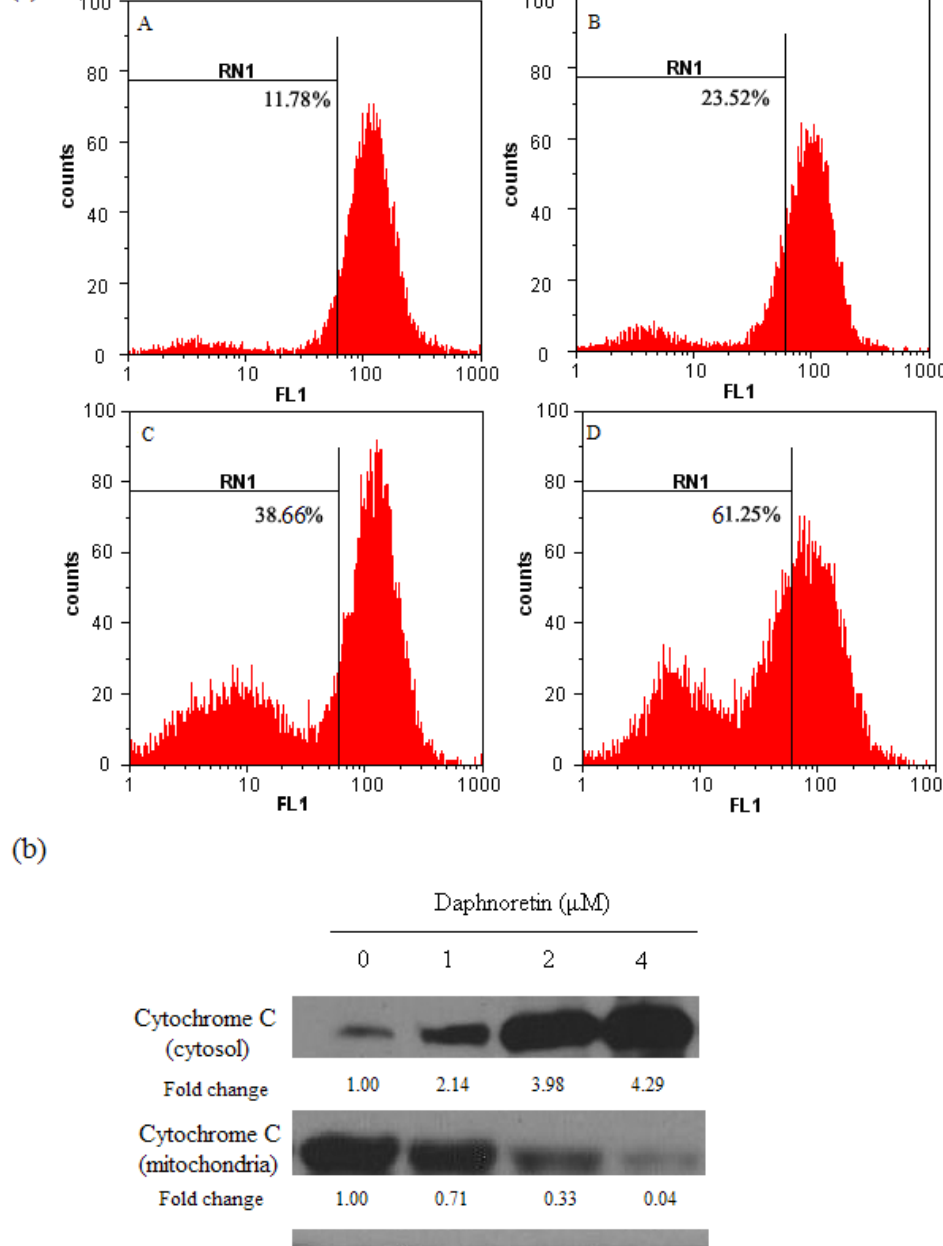
Figure 4. Disruption of Δψ and cytochrome c release during daphnoretin induced m apoptosis. ( a ), Mitochondrial membrane potential of HOS cells after treatment with daphnoretin by using Rh123 staining. (A) Treatment with 0 µM daphnoretin; (B) treatment with 1 µM daphnoretin; (C) treatment with 2 µM daphnoretin; (D) treatment with 4 µM daphnoretin; The experiments were repeated three times and representative photographs are shown. ( b ), Immunoblotting for the expression of cytochrome c in response to treatment with daphnoretin (0, 1 µM, 2 µM and 4 µM) for 48 h. The blots were stripped and reprobed with anti- β -actin antibody to normalize the protein loading. Bands were quantitated by densitometric analysis. Fold change represents the protein level of the daphnoretin-treated cells relative to the control cells